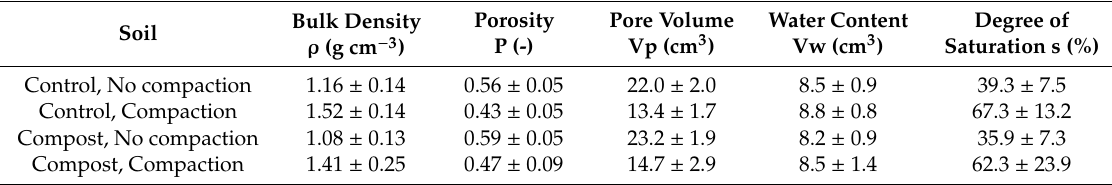
Table 2. Main soil physical properties of the control (unamended) and compost amended soils, not compacted and compacted.